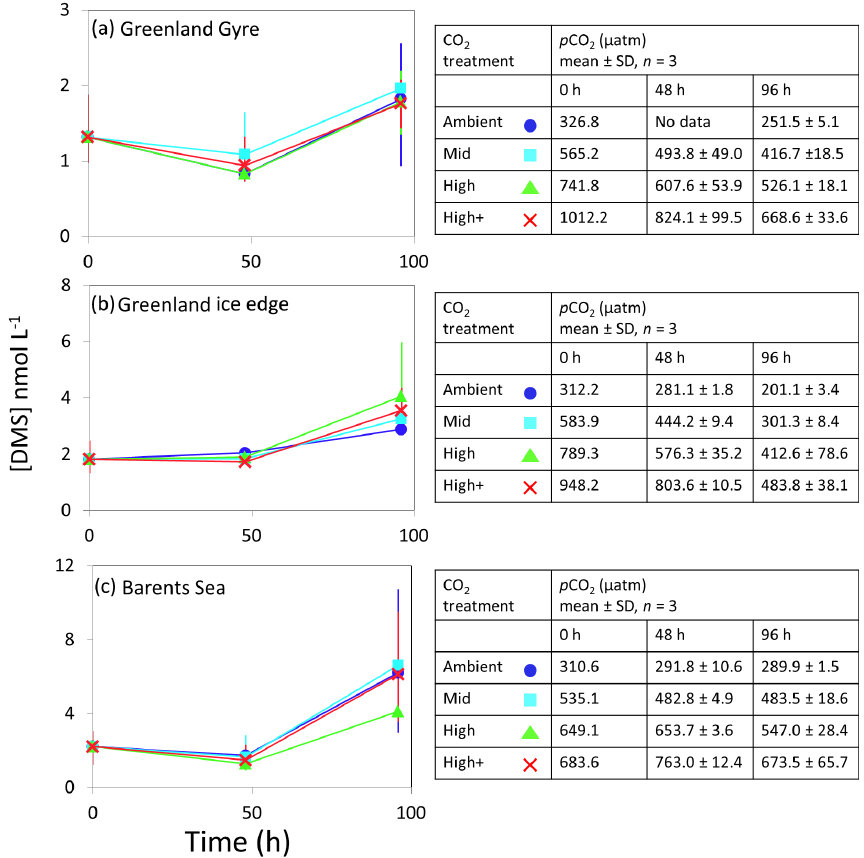
Figure 3. DMS concentrations (nmolL − 1 ) during experimental microcosms performed in Arctic waters. Data shown are the mean of tripli- cate incubations, and error bars show the standard error on the mean. Tables show measurements of p CO 2 (µatm) for each treatment at each sampling time point. Initial measurements (0h) were from a single sample, whilst measurements at 48 and 96h show mean ± SD of triplicate experimental bottles. Locations of water collection for microcosms shown in Fig.